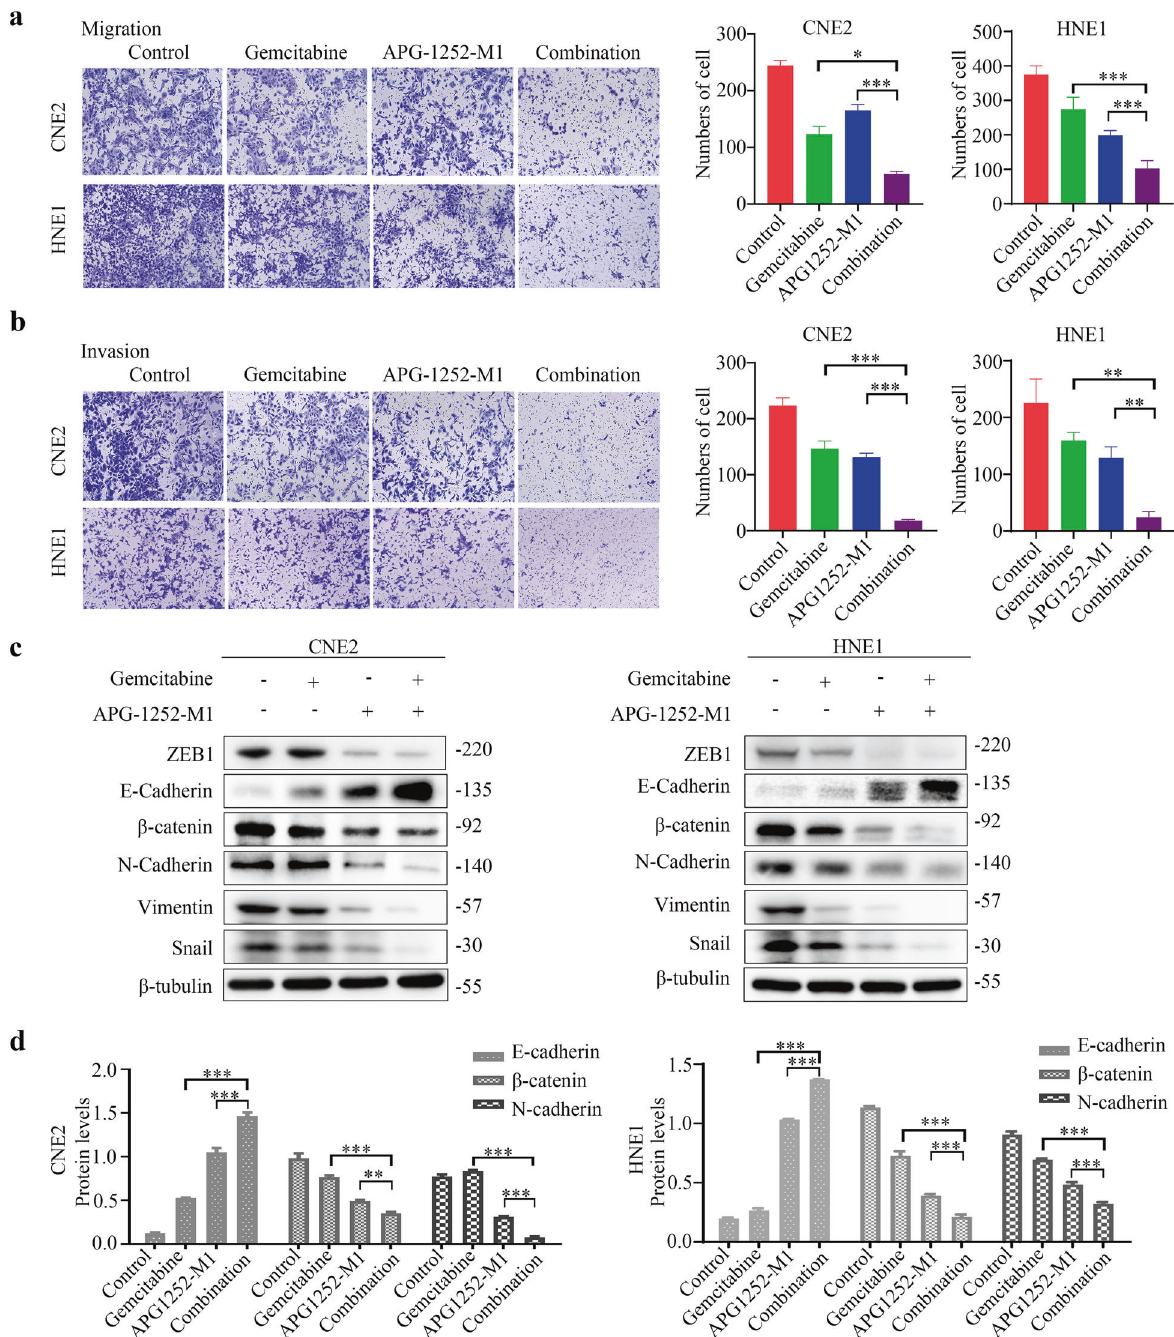
Fig. 3 APG-1252-M1 and gemcitabine suppress the biological processes of NPC such as cell migration, invasion, and EMT. a CNE2 and HNE1 cells were exposed to different treatments for 24 – 48 h, including APG-1252-M1, gemcitabine, or in their combination. To evaluate the NPC cells ’ migratory ability, Transwell migration assays were carried out. The experiments were conducted in triplicate, and all data are presented as the mean±SD. * P < 0.05, ** P < 0.01, *** P < 0.001. b CNE2 and HNE1 cells were exposed to different treatments for 24 – 48 h, including APG-1252-M1, gemcitabine, or their combination. To evaluate the NPC cells ’ invasive ability, Transwell invasion assays were carried out. The experiments were performed three times independently, and the data are shown as mean±SD. * P < 0.05, ** P < 0.01, *** P < 0.001. c , d Cells (CNE2 and HNE1) were exposed to different treatments for 24 – 48 h, including APG-1252-M1, gemcitabine, or their combination. Western blotting was applied to examine the expression of EMT markers (E-cadherin, N-cadherin, β -catenin, ZEB1, Vimentin, and Snail). β -tubulin was used as a loading control. * P < 0.05, ** P < 0.01, *** P < 0.001. Error bars indicate the standard deviation of three independently performed experiments. NPC nasopharyngeal carcinoma, EMT epithelial – mesenchyme